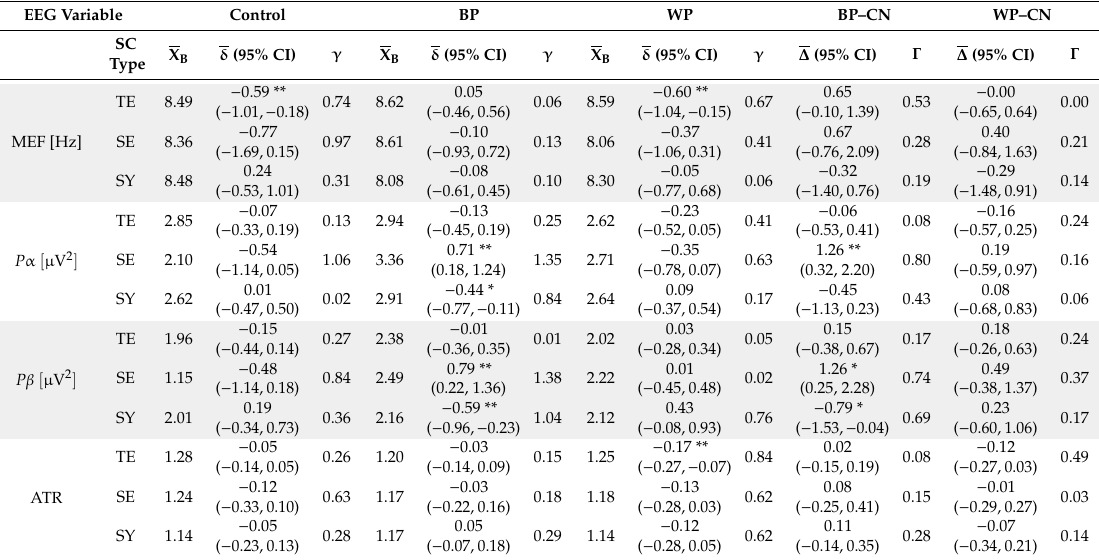
Table A1. Changes in EEG variables after FTPs according to SC types (ANCOVA results).